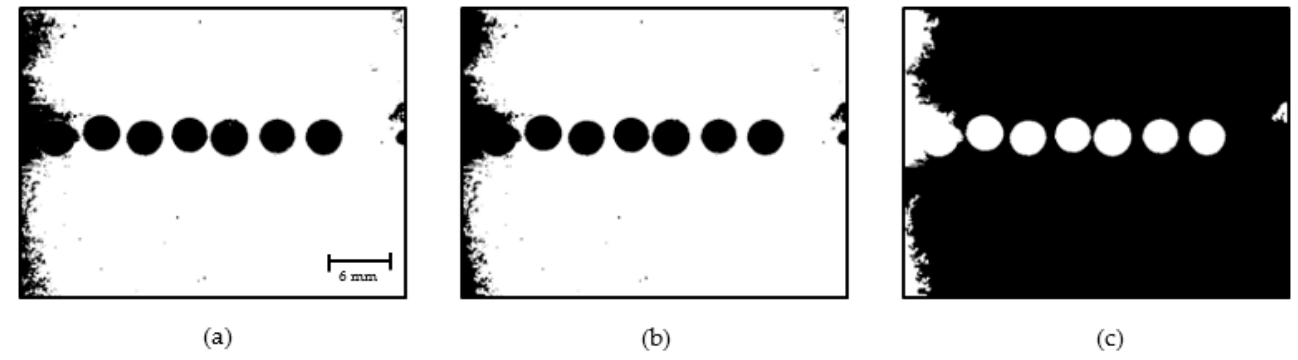
Figure 12. Morphological opening: ( a ) Binary image; ( b ) Opening step 1; ( c ) Opening step 2.